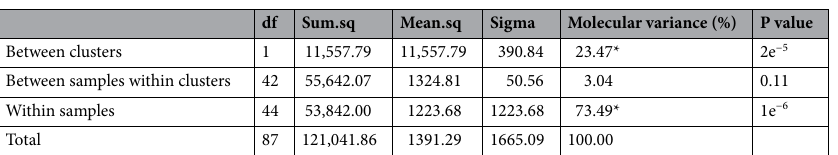
Table 1. Analysis of molecular variance (AMOVA) among samples used in this study. df degrees of freedom. *Significant.